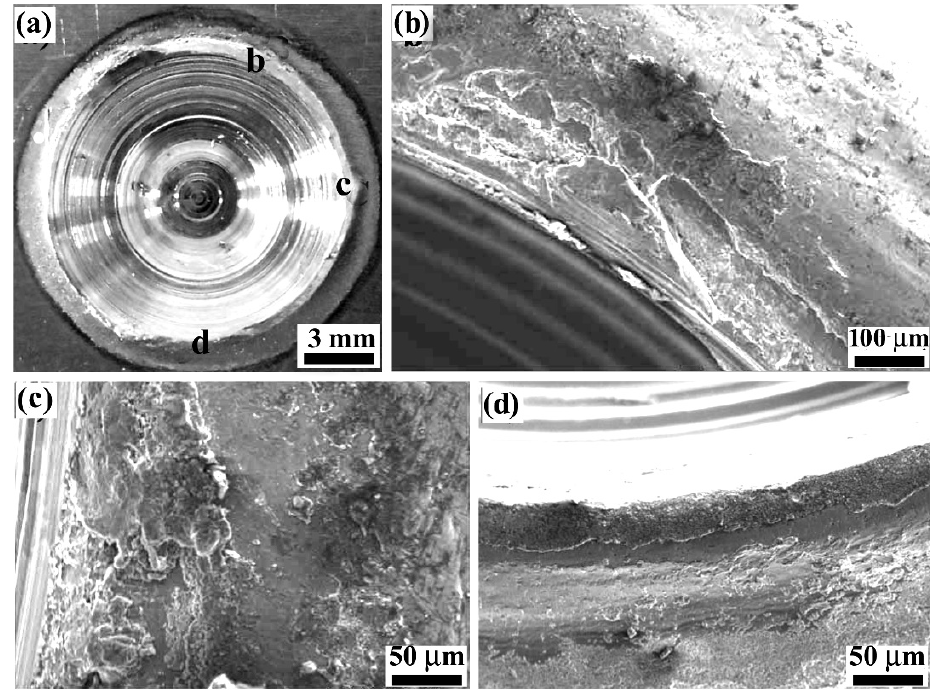
Figure 16. SEM images of the fracture surfaces in the R-FSSW sample tool rotational speed of 1400 rpm: ( a ) Fracture surface on the lower sheet; ( b – d ) magnified views at points ( b – d ) in ( a ), respec- tively.